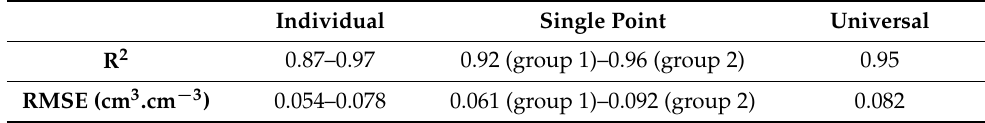
Table 4. Statistical metrics for different calibration